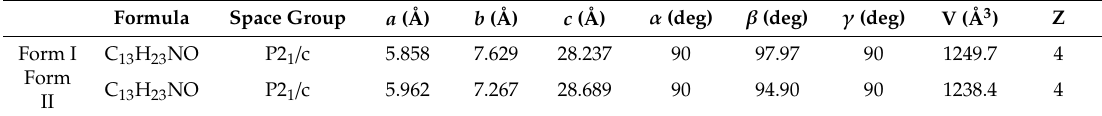
Table 1. The lattice constants of β -lactam, which were taken from [11].